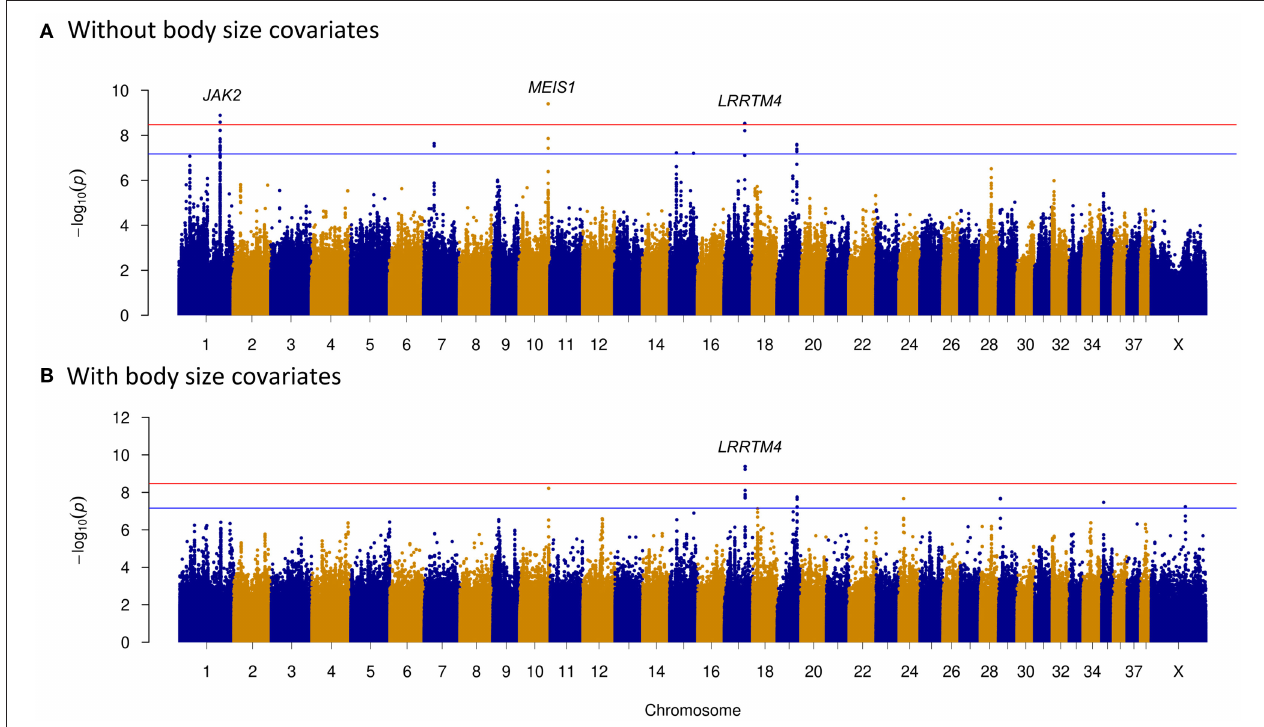
FIGURE 3 | Genome-wide association study (GWAS) of dog predation analysis between hound and herding group dogs. Manhattan plots demonstrate the p -value distribution across all chromosomes. The Bonferroni and suggestive GWAS significance thresholds are indicated with the red and blue horizontal lines, respectively. (A) Without including body size as a covariate. JAK2 , MEIS1 , and LRRTM4 were the genes nearest to the significantly associated regions of CFA1, CFA10, and CFA17. (B) Including body size as a covariate. Significantly associated region of CFA17 remained after incorporating body size covariates into